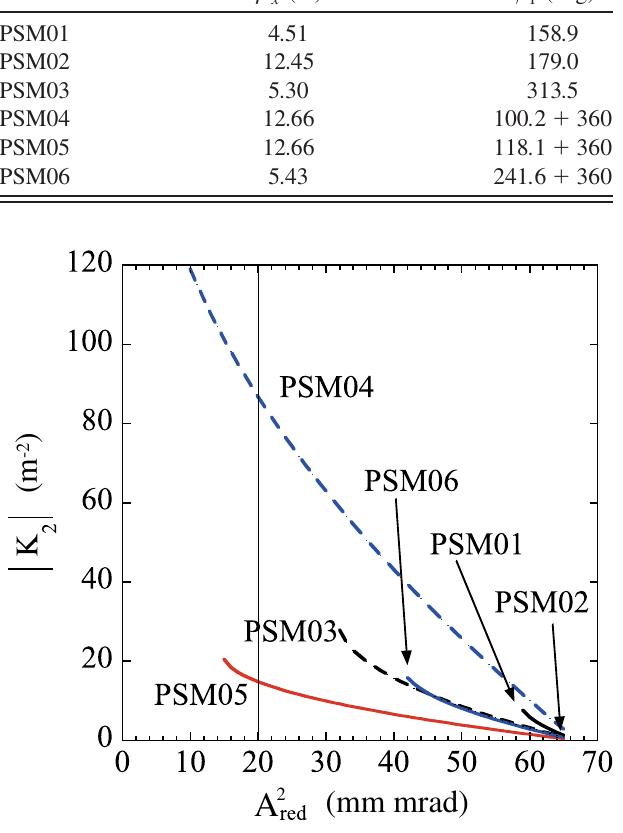
FIG. 6. (Color) PSM field strengths at the PSM locations as a function of the square of the reduced injection amplitude ( A 2 red ). In the calculations, the injection angle of the injected beam is ¼ 2 : 5 mrad x 0 0